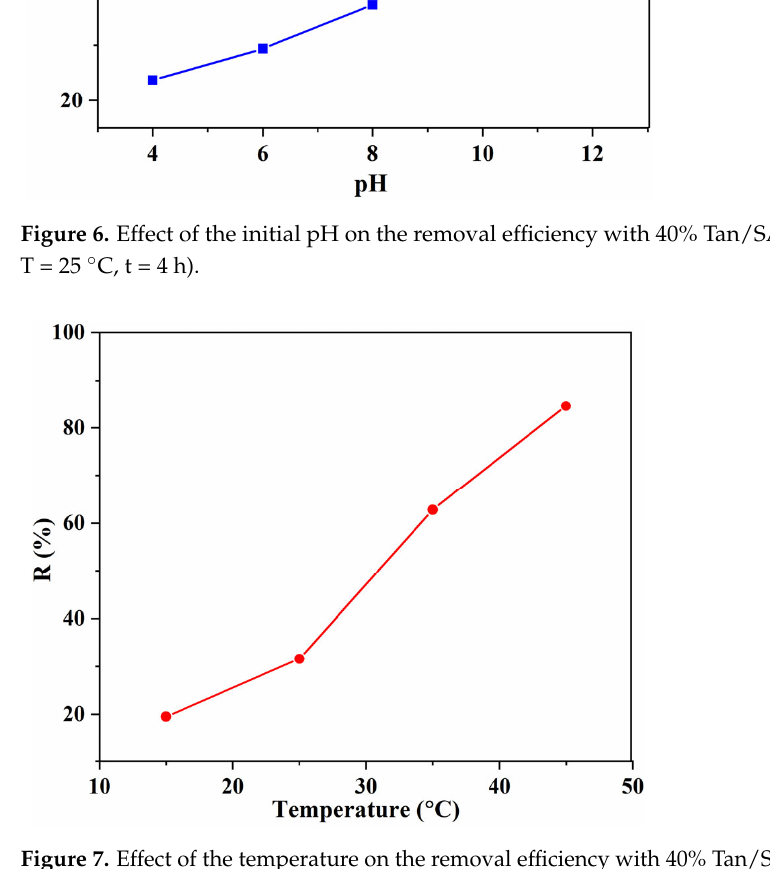
Figure 6. Effect of the initial pH on the removal efficiency with 40% Tan/SA beads ( C 0 = 80 mg/L, T = 25 °C, t = 4 h).